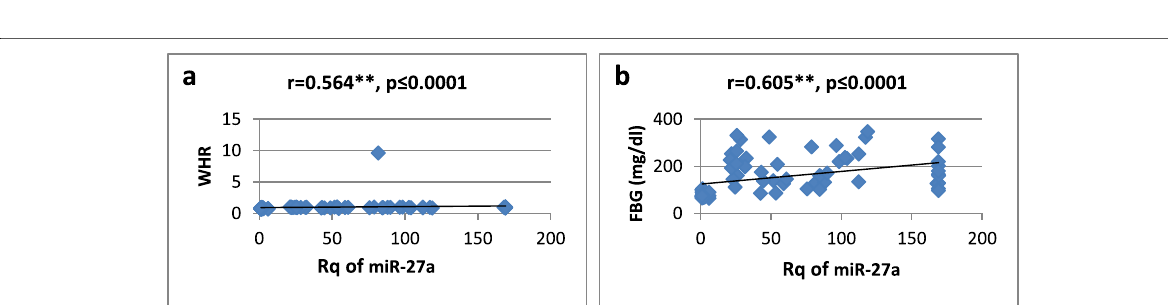
0.564) and FBG ( r 0.605), where “**” means significant at = =